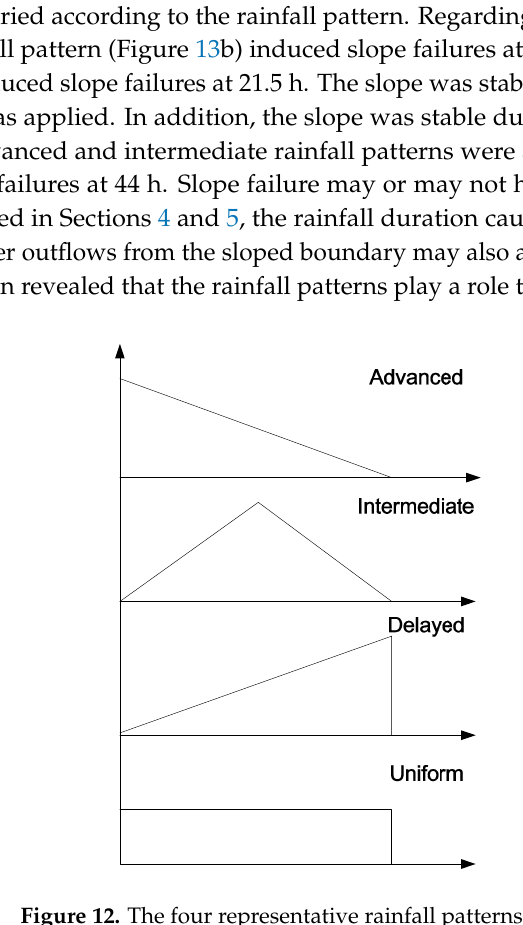
Figure 12. The four representative rainfall patterns [11].